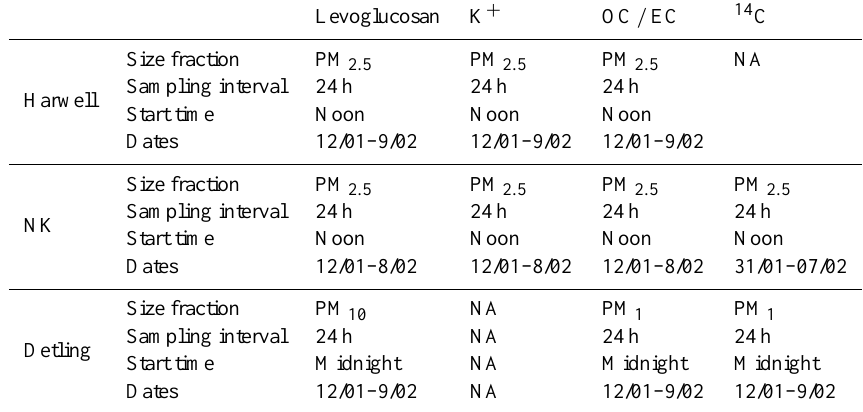
Table 1. Summary of sampling methodology for the filter analyses in the winter campaign. Note NA means not available. Levoglucosan K + OC / EC Sampling Harwell